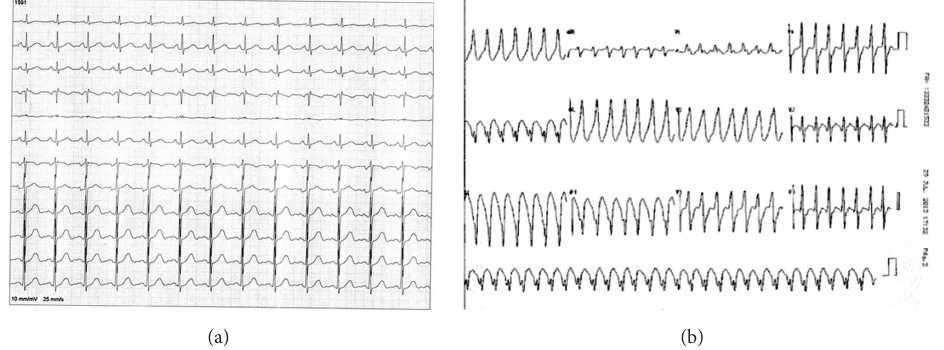
Figure 1: (a) Baseline electrocardiogram, showing no atrioventricular or intraventricular conduction abnormalities, nor fragmenting of the QRS complex. (b) Electrocardiogram performed in the emergency department showing monomorphic ventricular tachycardia with Rr’ pattern in V1, late R/S transition, and left axis